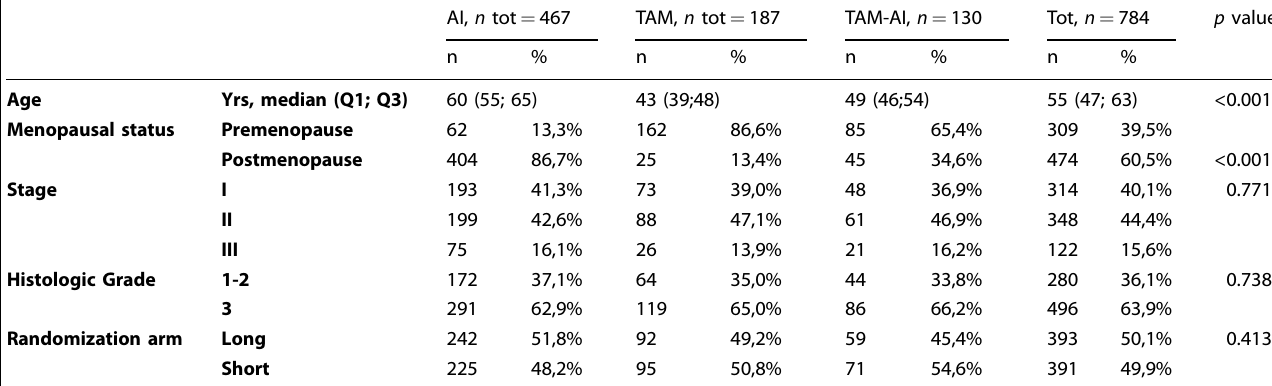
Table 1. Patients ’ characteristics according to the type of adjuvant endocrine therapy.